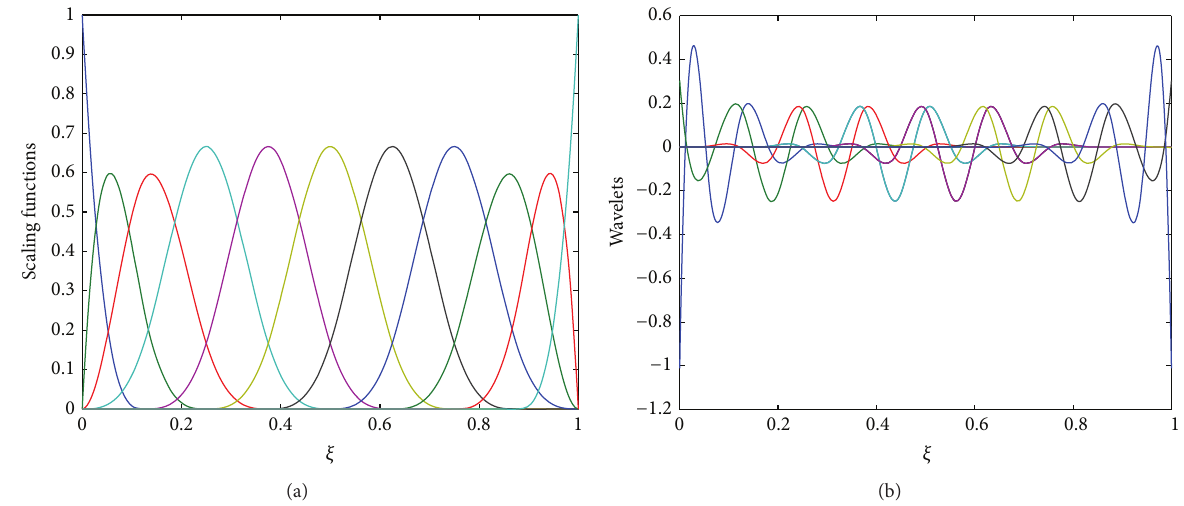
Figure 1: BSWI4 3 on the interval [0, 1] : (a) scaling functions and (b) wavelets.